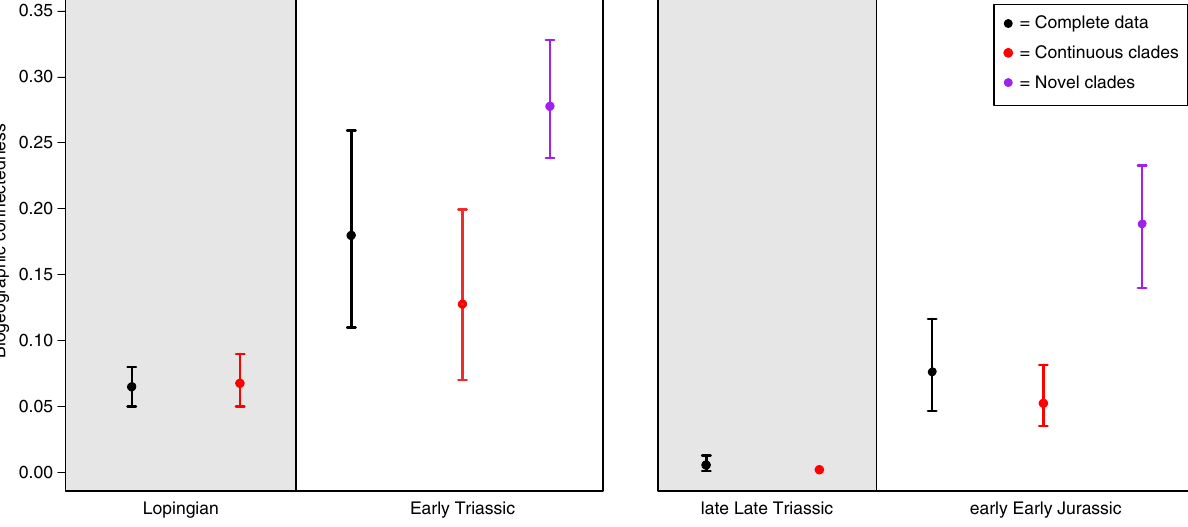
Fig. 4 Results from BC analysis of taxonomic subsets. Comparison of results for the data subsets across the Permian – Triassic a and Triassic – Jurassic b mass extinctions. Results for the entire data set are in black , those for less inclusive clades showing high survivorship in red , and those for the most recently diverging taxa in purple . Ninety- fi ve percent con fi dence intervals, calculated from jackkni fi ng with 10,000 replicates, are indicated